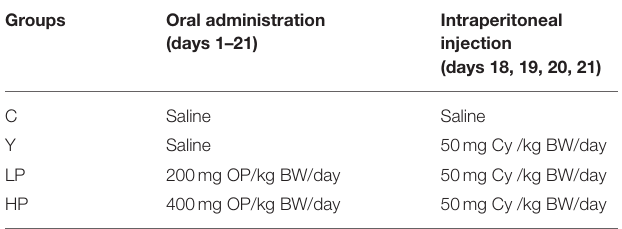
TABLE 1 | Experimental grouping of mice.